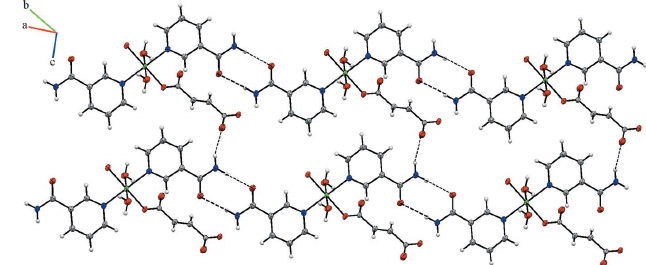
Figure 2 A partial view of the crystal packing of the title compound. Dashed lines indicate the hydrogen bonds (see Table